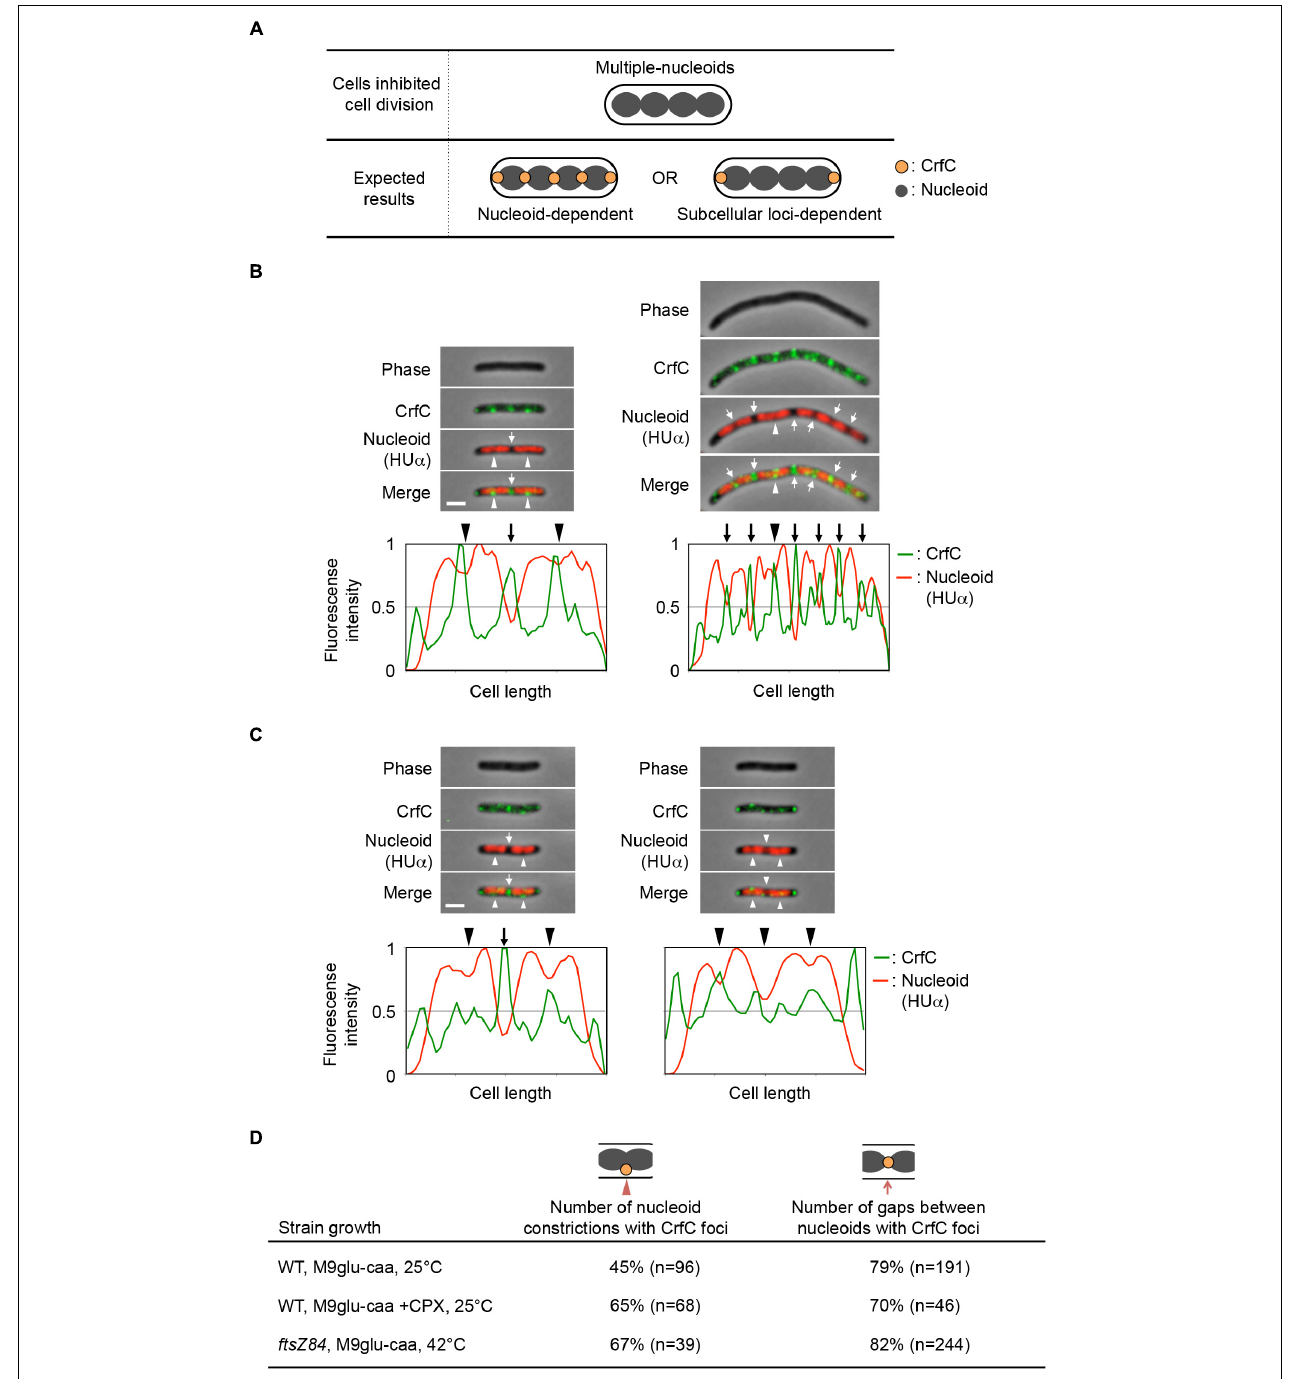
FIGURE 6 | Localization of CrfC and nucleoids in filamentous cells containing multiple nucleoids. (A) Characteristics of ftsZ84 and cephalexin-treated wild-type cells after the inhibition of cell division. The cells were elongated, and replicated nucleoids were partitioned in each cell (upper panel). (B–C) Localization of CrfC-Venus and nucleoids in MECS150 ( ftsZ84 ) cells (B) and cephalexin-treated MECS133-K (wild-type ftsZ ) cells (C). The ftsZ84 cells were incubated at 42 ◦ C for 2 h and the wild-type ftsZ cells were incubated at 25 ◦ C for 2 h in the presence of cephalexin. The arrowheads indicate the nucleoid constrictions, and the arrows indicate the inter-nucleoid gaps. Scale bar is 2 µ m. Normalized fluorescence intensities of CrfC (green line) and nucleoid (red line) along the length of the cell are shown below each image. (D) Percentages of cells with CrfC foci at nucleoid constrictions or at inter-nucleoid gaps in MECS133-K (WT; wild-type), MECS150 ( ftsZ84 ), and cephalexin-treated MECS133-K cells. Wild-type data from Figure 2 are shown for comparison. n; number of nucleoid constrictions or inter-nucleoid gaps analyzed. CPX, cephalexin.